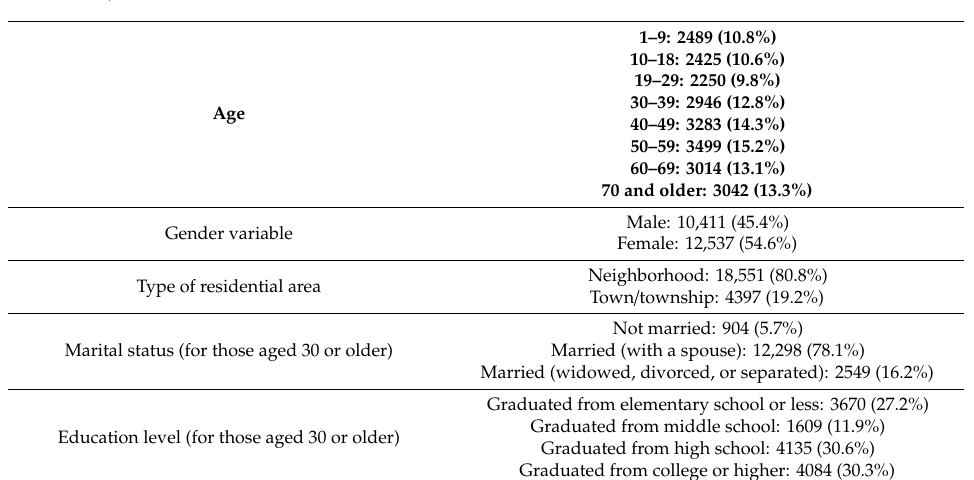
Table 1. Demographic variables in Korea National Health and Nutrition Examination Survey (KNHANES) VI.